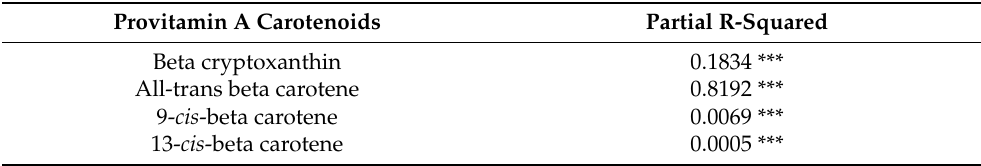
Table 9. Regression of provitamin A carotenoids on total provitamin A content of extra-early provitamin A quality protein maize inbreds analyzed using high-performance liquid